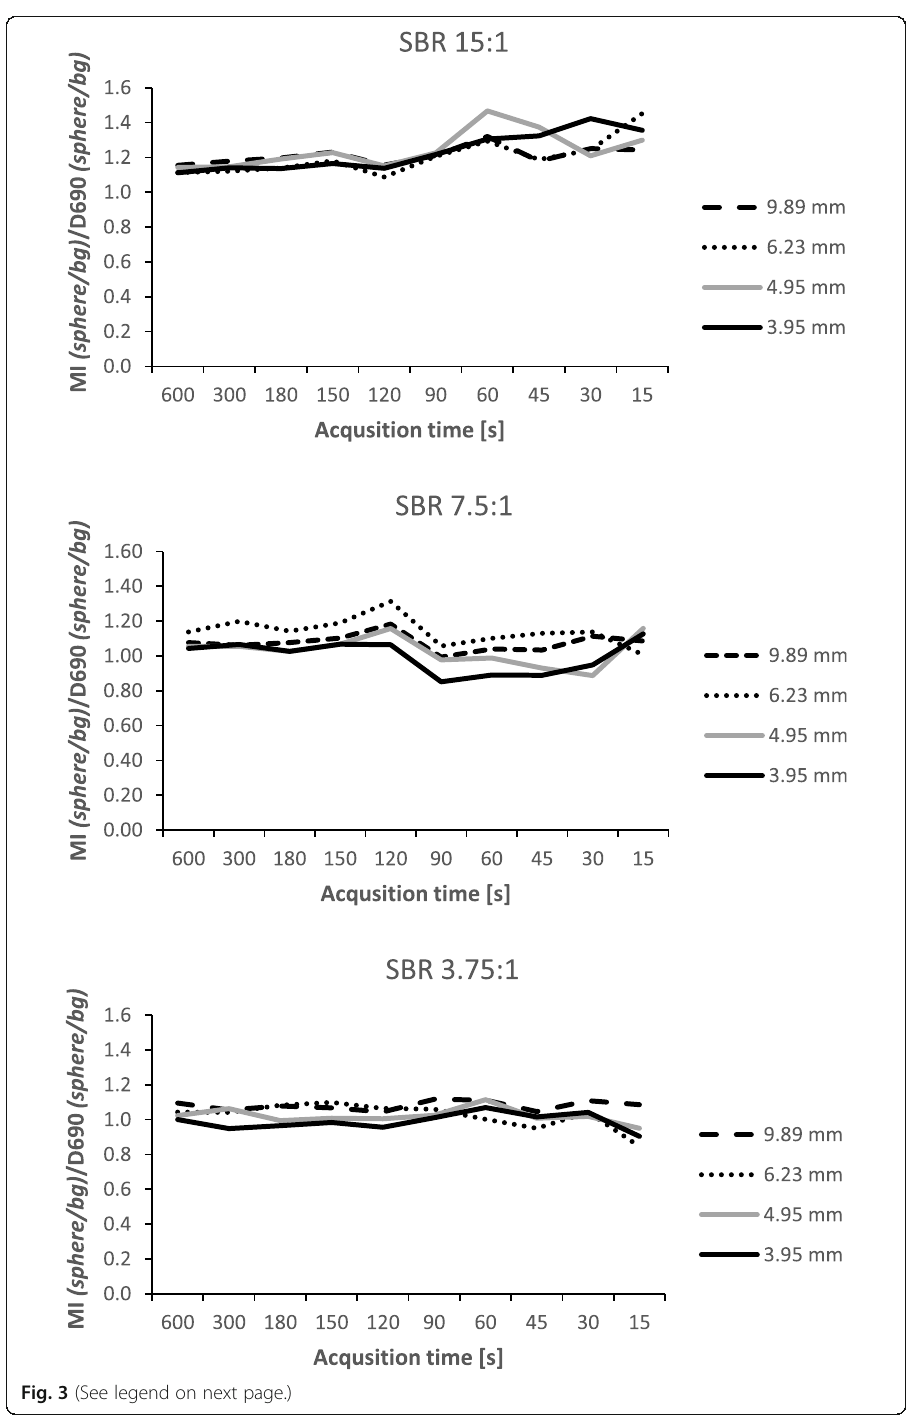
Fig. 3 (See legend on next